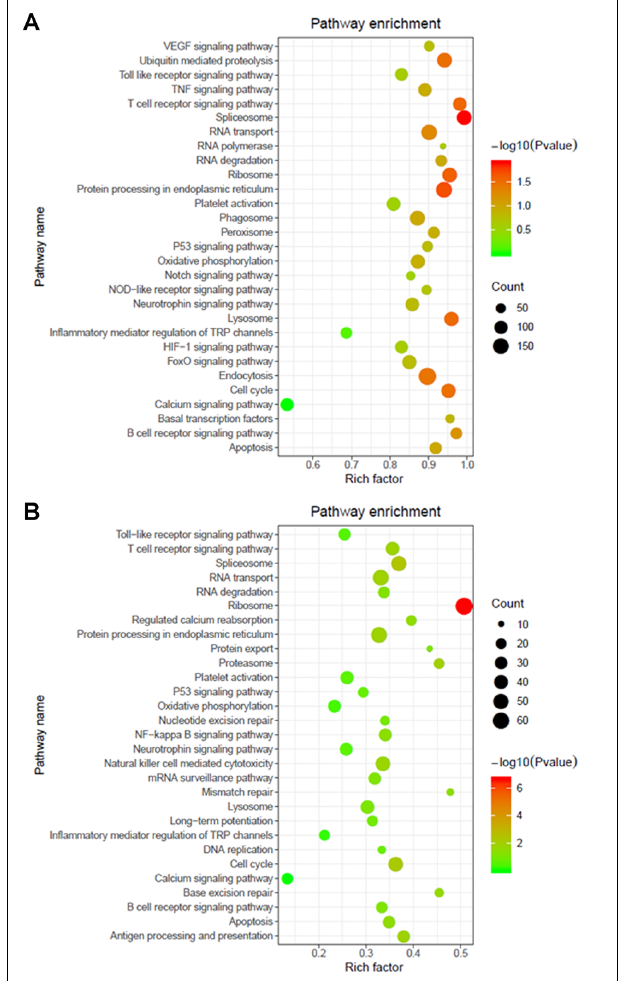
FIGURE 3 | Pathway analysis of differentially expressed RNAs. (A) GO and Kyoto Encyclopedia of Genes and Genomes (KEGG) pathway analyses of potential genes associated with differentially expressed lncRNAs. (B) GO and KEGG pathway enrichment analyses of differentially expressed mRNAs. The Rich factor represents the degree of enrichment. The node size shows the number of selected genes, and the color scale represents the –log ( P